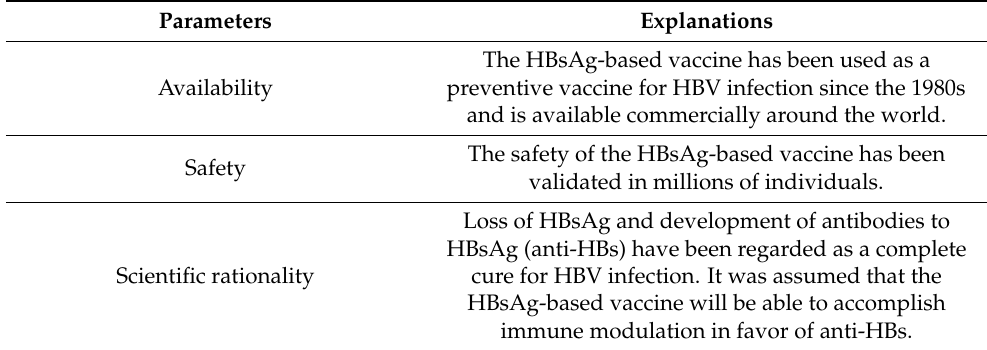
Table 2. HBsAg-based vaccine as the ideal candidate for “vaccine therapy” of CHB patients. Parameters